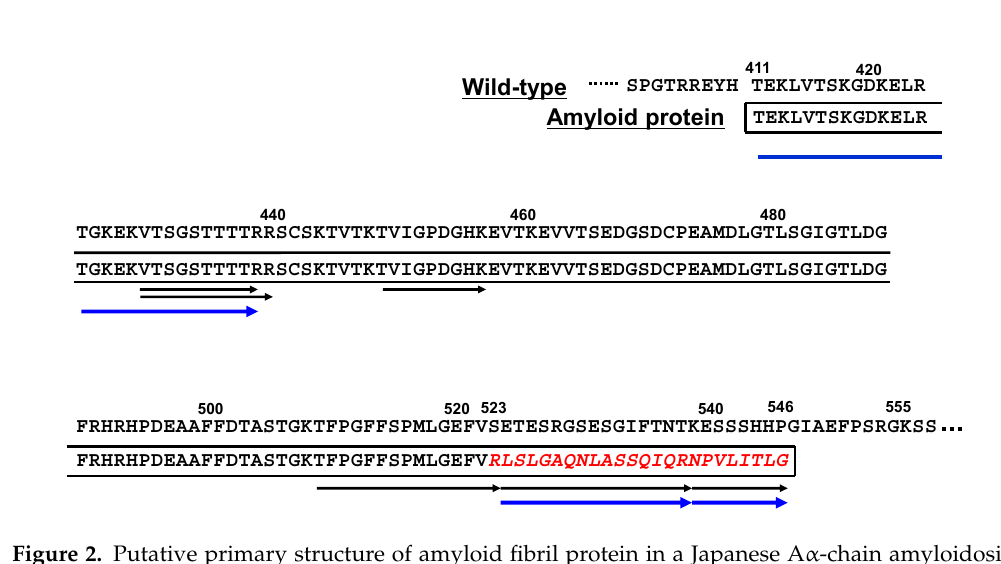
Figure 2. Putative primary structure of amyloid fibril protein in a Japanese A α -chain amyloidosis patient [14]. Amyloid protein in this patient is assumed to be composed of both wild-type sequence (residues 411–522) and an additional fragment (red italic letters) induced by the frameshift variant (residues 523–546). Black arrows denote tryptic peptides detected at laser microdissection (LMD) isolation of glomerular amyloid, and blue arrows denote Arg-C peptides detected at in-gel digestion on SDS-PAGE analysis of duodenal amyloid.